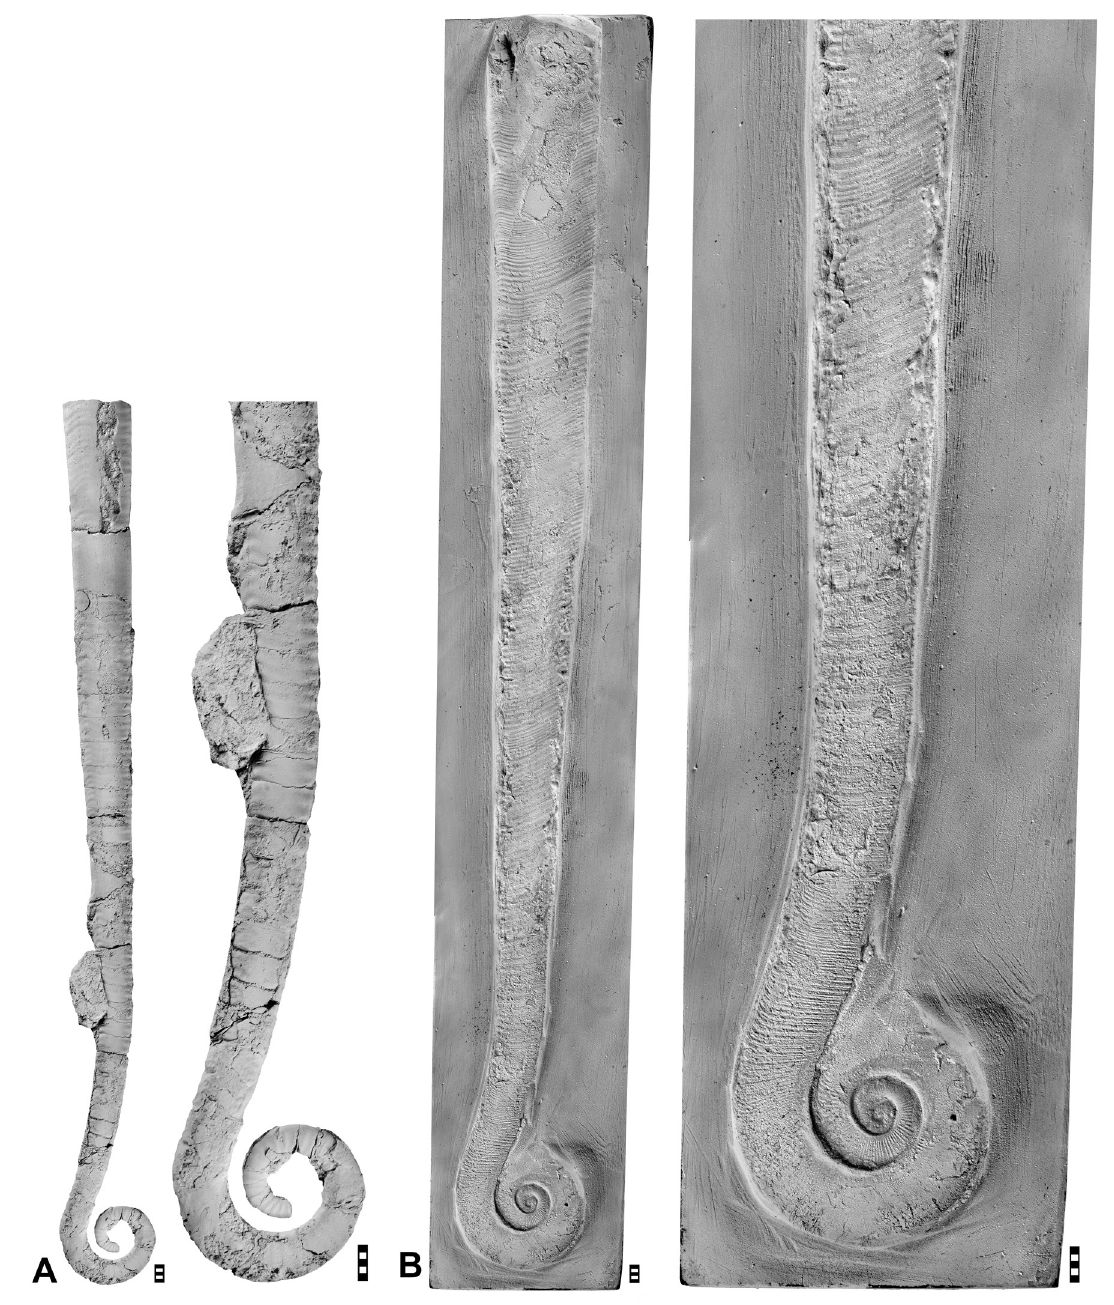
Fig. 69. Species of Trilacinoceras Sweet, 1958. A . Trilacinoceras filix sp. nov., holotype MB.C.30557 (Neben & Krueger 1961 Coll.) from the Upper Grey Orthoceratite Limestone of Rerik (Ostsee) (Mecklenburg-Vorpommern); previously figured by Neben & Krueger (1971: pl. 31 fig. 4). B . Trilacinoceras cf. hunanense Lai & Qi, 1977, specimen MB.C.29655 (Bottke Coll.) from the Datianba Formation of Songtao County (Guizhou, South China). Scale bar units = 1